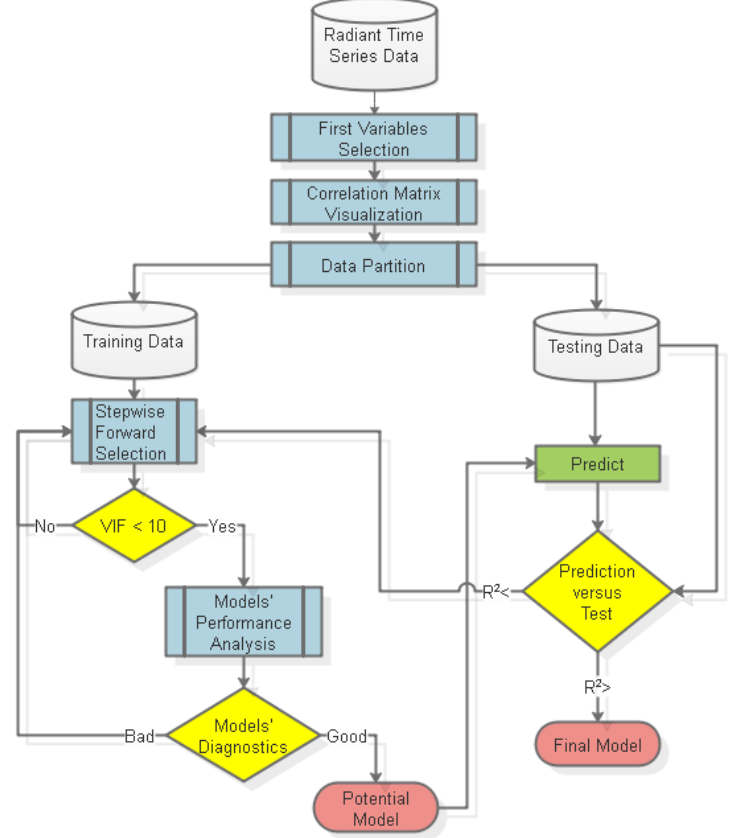
Figure 1. A diagram depicting the used methodologies of the paper.